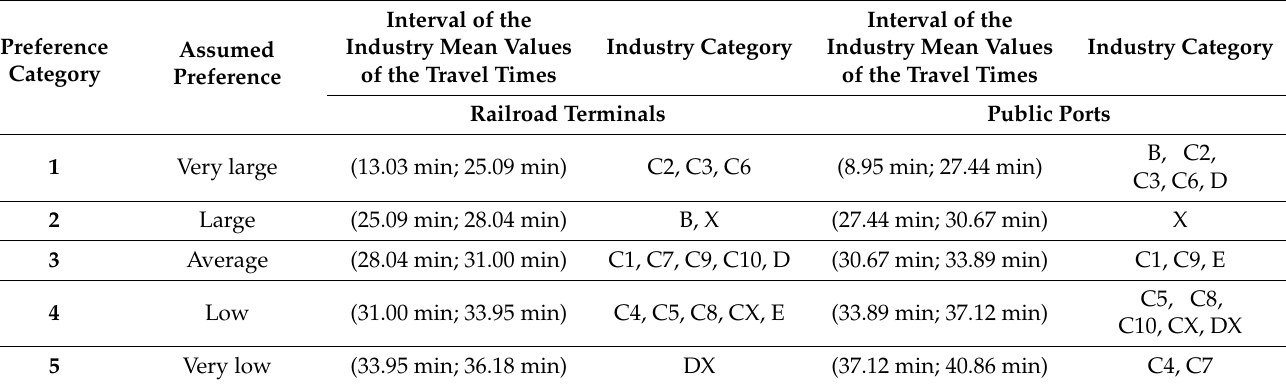
Figure 10. Travel time to railroad terminals by industry category. Circles indicate outliners. Table 4. Preference categories and categorization of the